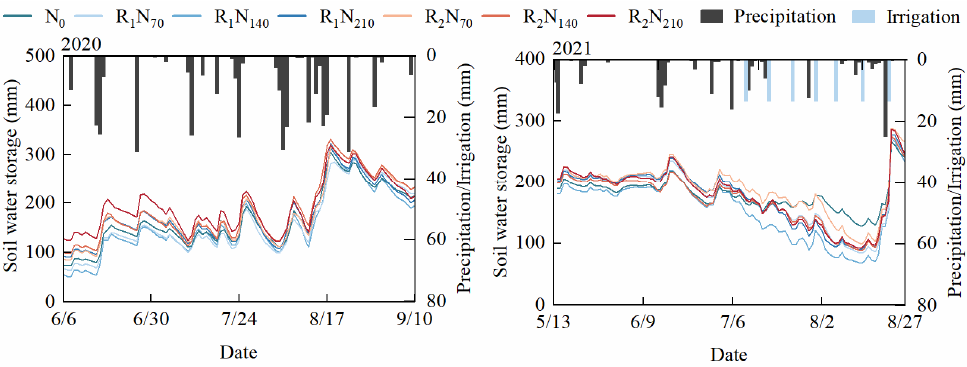
Figure 9. Dynamics of soil water storage in the 0–80 cm soil layer under different treatments in 2020 and 2021.